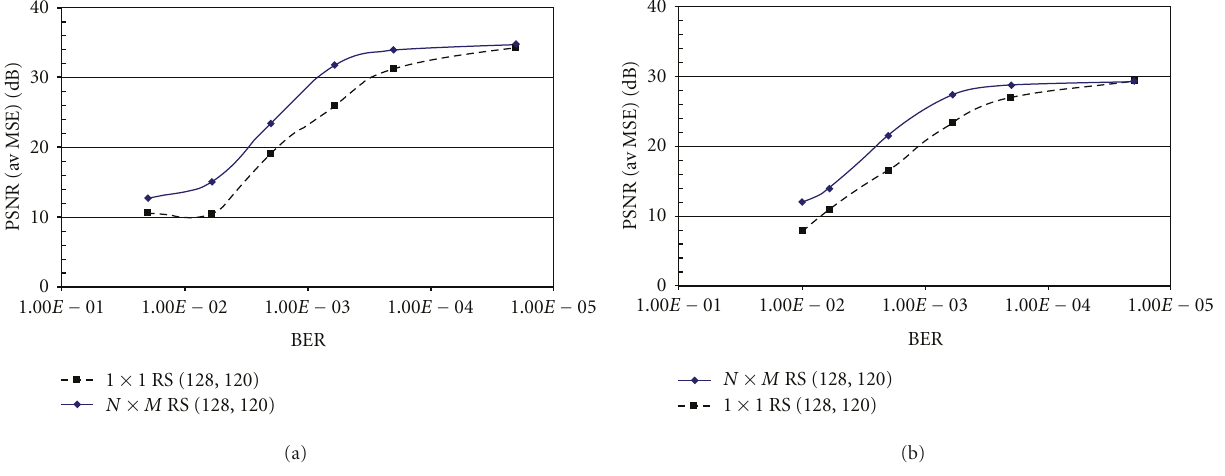
Figure 16: Comparing 1/1 and N / M redundancy approach performance for “Foreman” and “Mobile” QCIF sequence with RS(128,120) protection, BSC